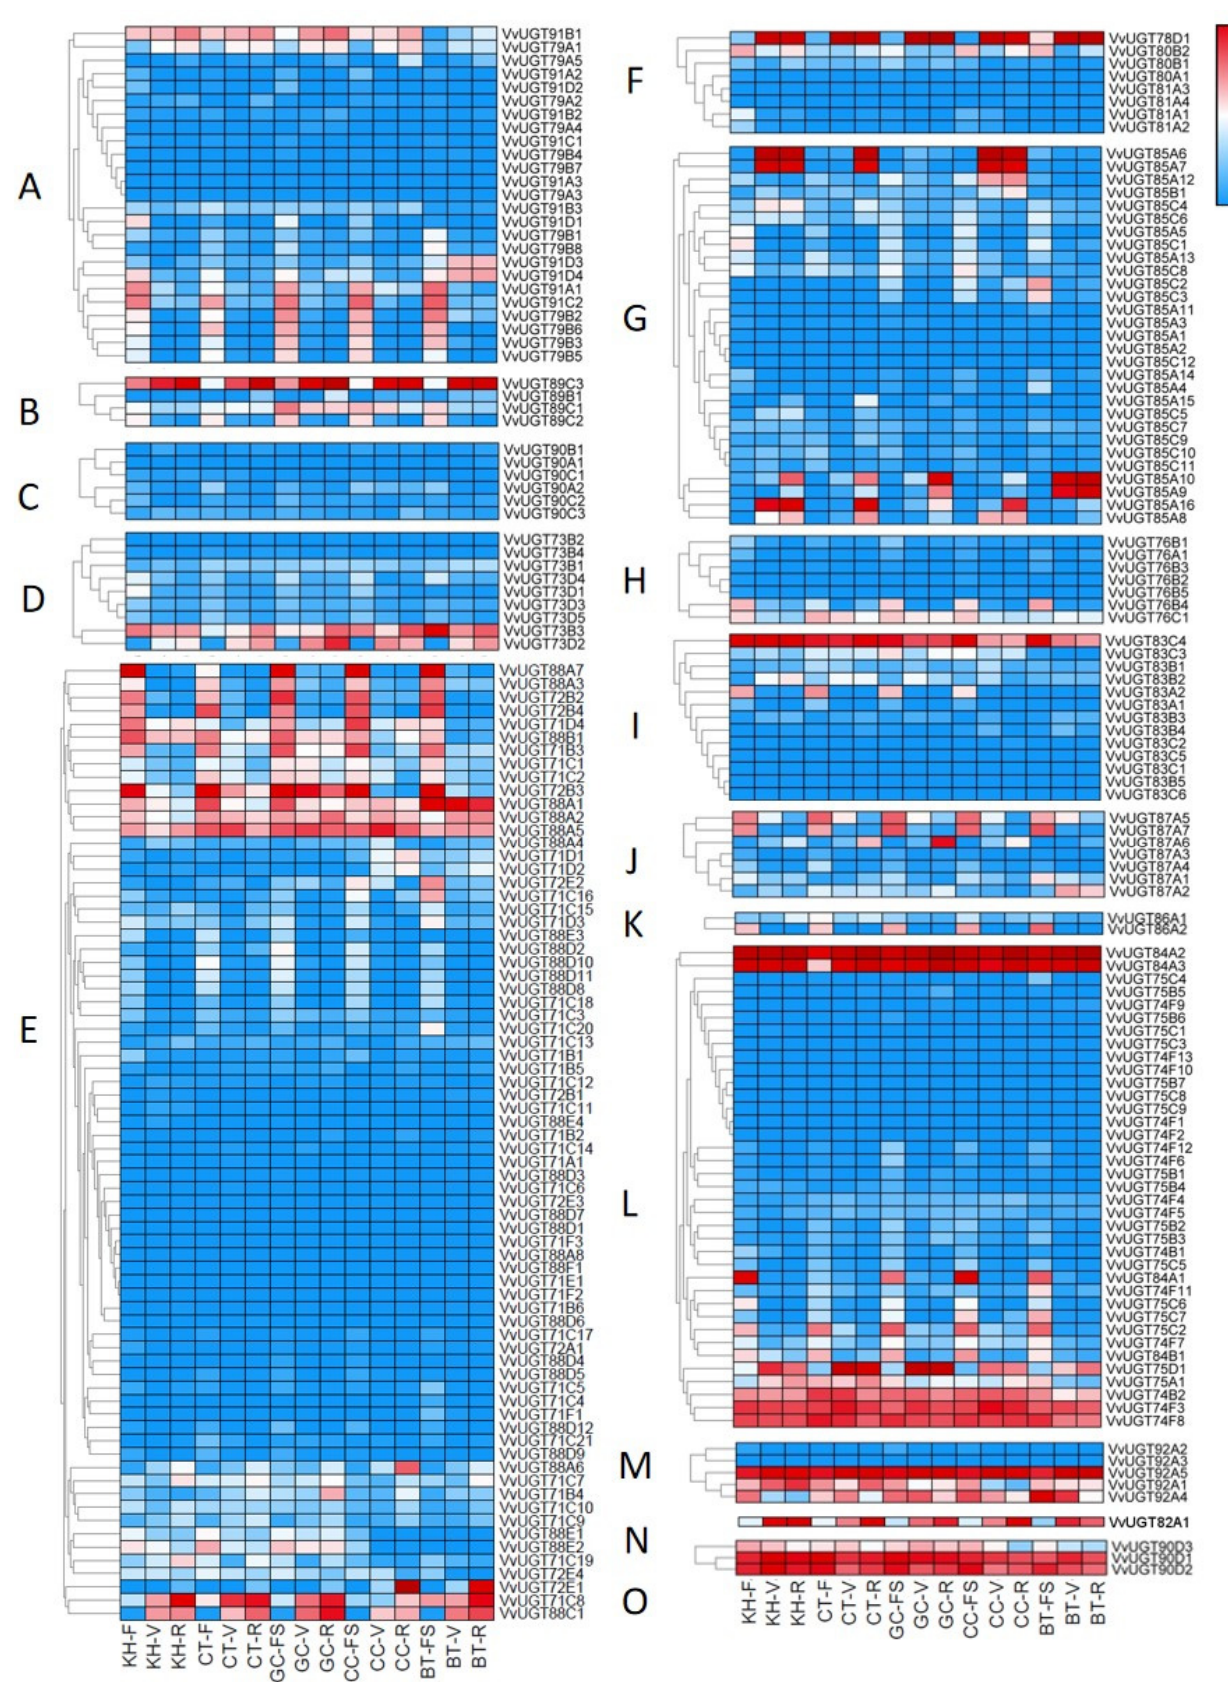
Figure 6. Expression profiles of UGT members at different development stages of grape fruit.